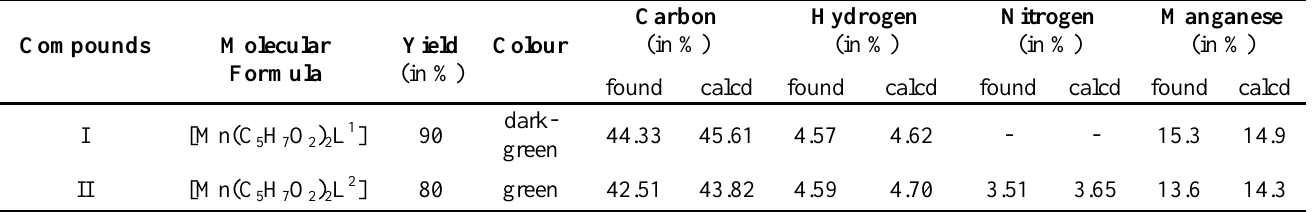
Table 1 . Data of the basic analysis of the investigated compounds (L 1 = -OCO-CH=CH-COOH, L 2 = -OCO-CH=CH-CONHOH).